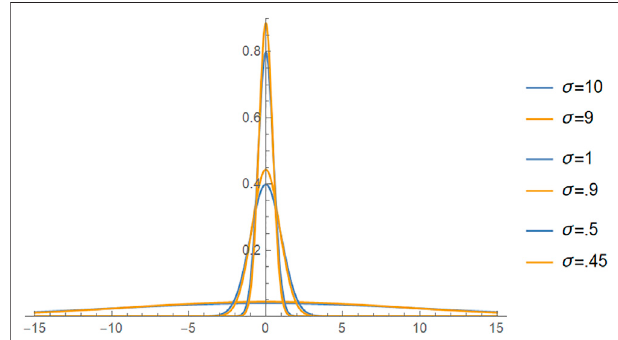
FIGURE 2 | N (0, σ 2 ) for three groups. g The bottom pair is σ = 10, 9; the middle pair is σ = 1, 0.9; and the top two, which are the most different are σ = 0.5,